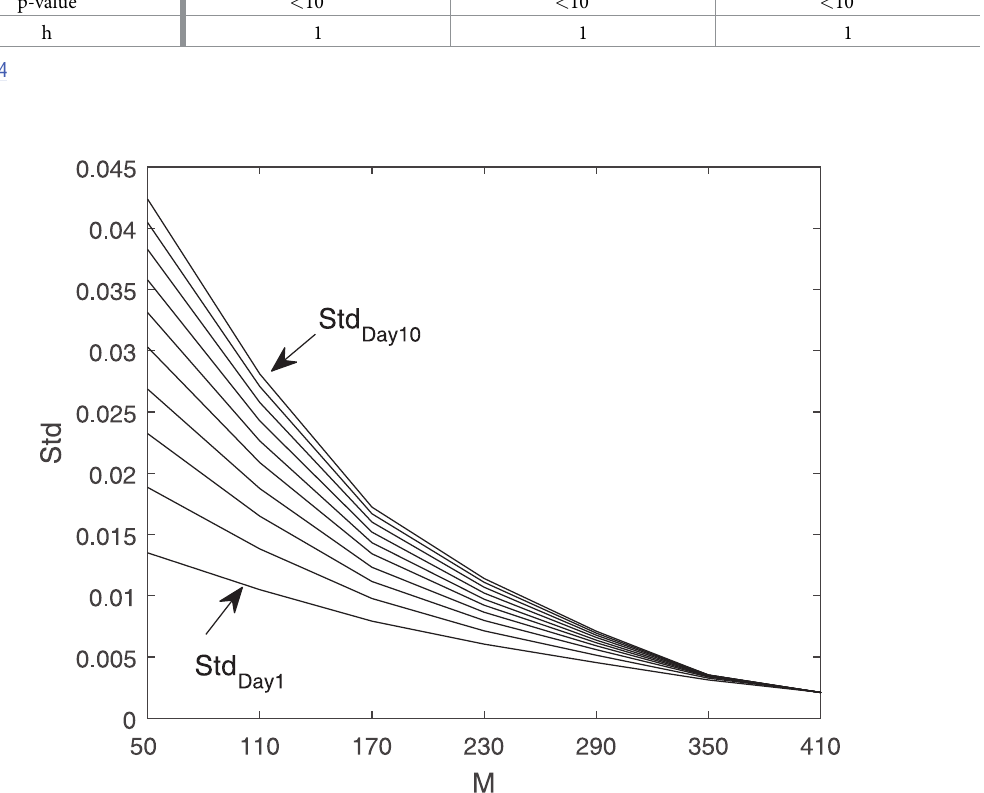
Fig 8. Standard deviation of individual days of estimation, RD: Solid